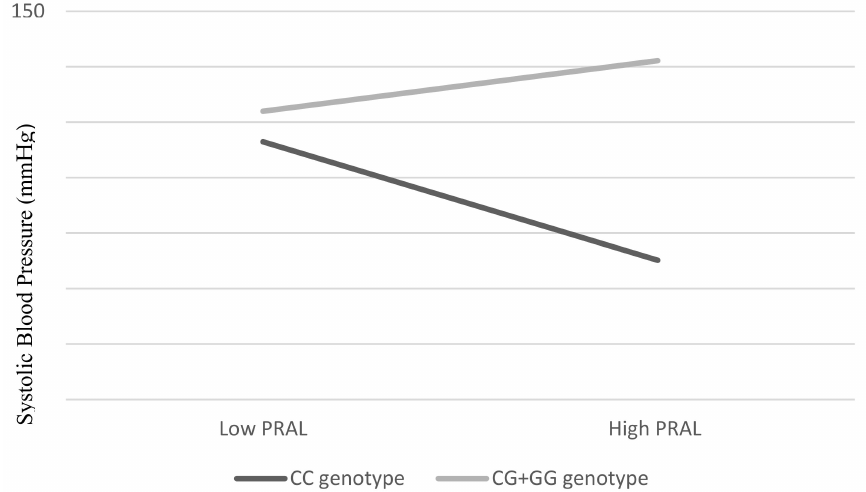
Figure 1. Interaction effect between PRAL (mEq/d) and SNP rs1800796 on SBP. An overall p value was obtained by hierarchical multiple linear regression. Estimates were adjusted for age (continuous), BMI (continuous), total cholesterol (continuous), and FBG